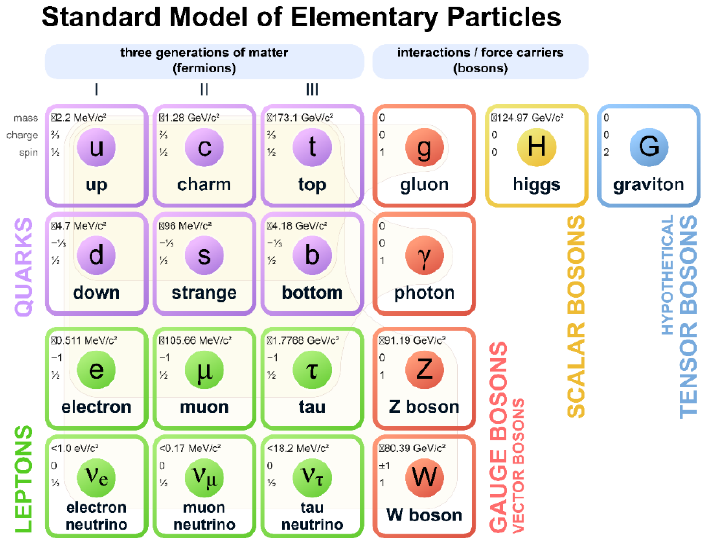
Figure 5. An updated scheme of SM extended to the hypothetical gravitons . The particles, interpreted in QFT as quanta of the relative (material and interaction) fields (see text), are subdivided into: (1) Three generations (families) of “fermions” , i.e., the quanta of the respective “matter fields”, obeying the Fermi-Dirac statistics , i.e., because all have a fractional “spin”, they occupy distinct levels of energy at their ground (minimum energy) state, such as electrons in the atom. Each generation is constituted by two massive “quarks” and two massive but lighter “leptons”. The first generation of fermions, manifesting themselves at the universe lower energies (temperatures), are particles constituting the atoms of our ordinary experience (quarks “up” and “down” constituting protons and neutrons (“baryons”) in the atom nucleus, plus the “electrons” and the “electronic neutrinos” of atoms). (2) Three types of massive and massless “bosons”, i.e., all obeying the Bose–Einstein statistics . Specifically, because all having an integer spin, at the ground state, they all occupy the same energy lower level. They are (a) the “gauge (carrier) bosons” of the three quantum force fields: “strong” (massless gluons ), “electromagnetic” (massless photons ), “weak” (massive Z, W bosons ); (b) the “scalar bosons” of the Higgs fields (massive Higgs bosons ); and (c) the “tensor bosons” of the gravitation field (massless gravitons ) of the quantum gravity theory, now only hypothetical.